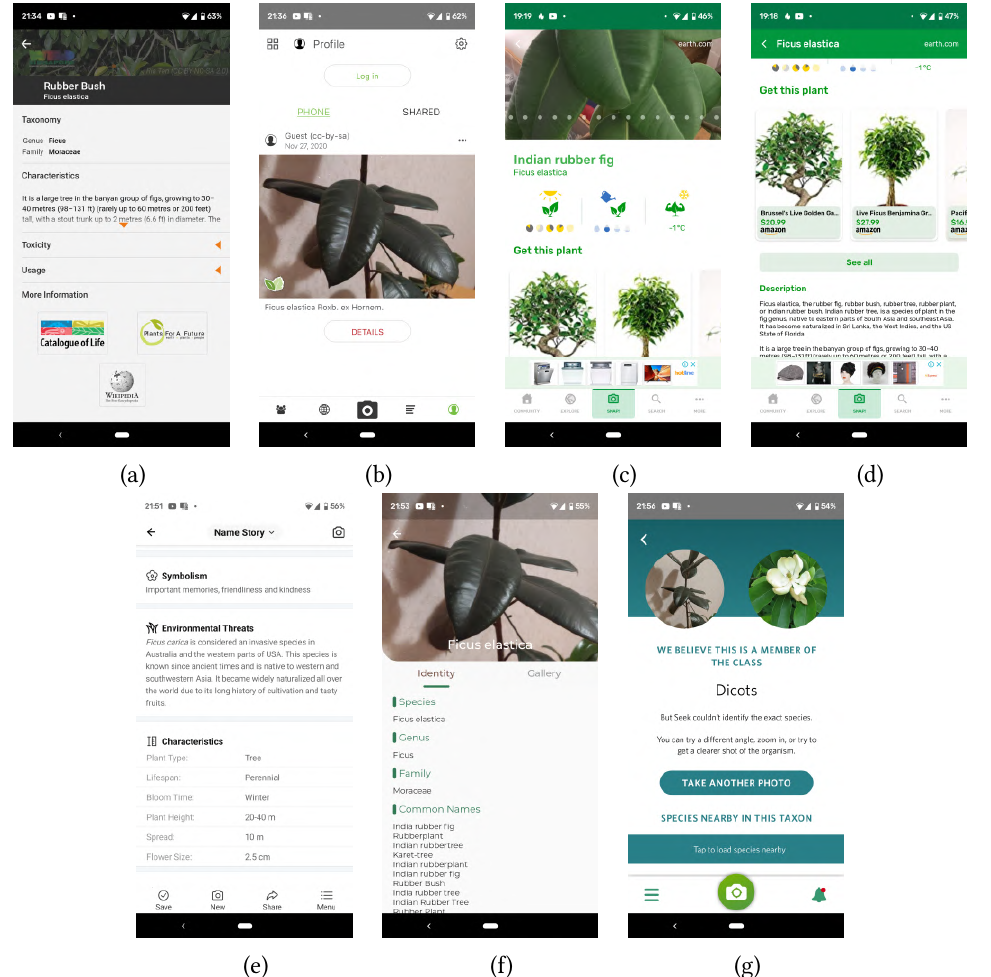
Figure 4: Data on identified plant Flora Incognita (a), PlantNet (b), PlantSnap (c, d), PictureThis (e), LeafSnap (f), and Seek